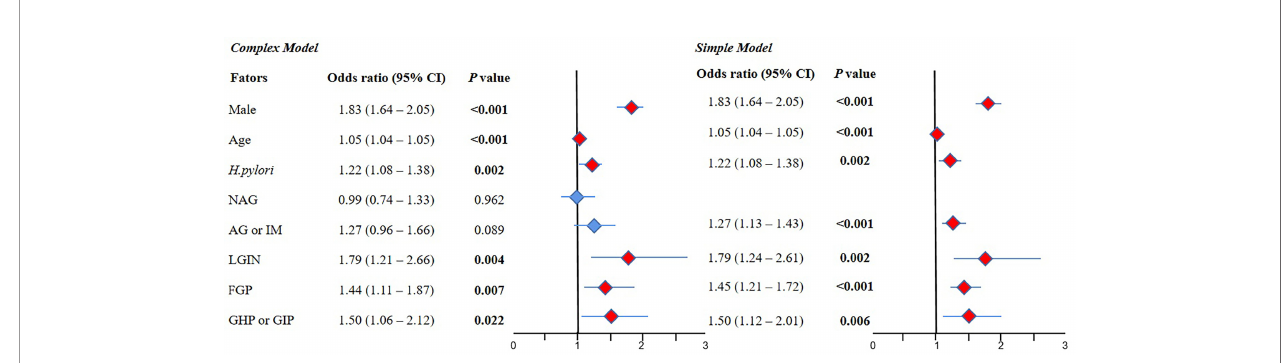
FIGURE 3 | The result of multivariate logistic regression for the AP group compared with the normal group. 95% CI, 95% con fi dence interval; NAG, non-atrophic gastritis; AG or IM, atrophy/intestinal metaplasia; FGP, gastric fundus gland polyps; GHP or GIP, hyperplastic/in fl ammatory gastric polyps; LGIN, low-grade intraepithelial neoplasia. Complex model: All variables were included, and then P values were calculated separately. Simple model: Based on the complex model and the stepwise regression method, an optimal simple model is obtained, which is automatically screened according to the Akaike information criterion (AIC)